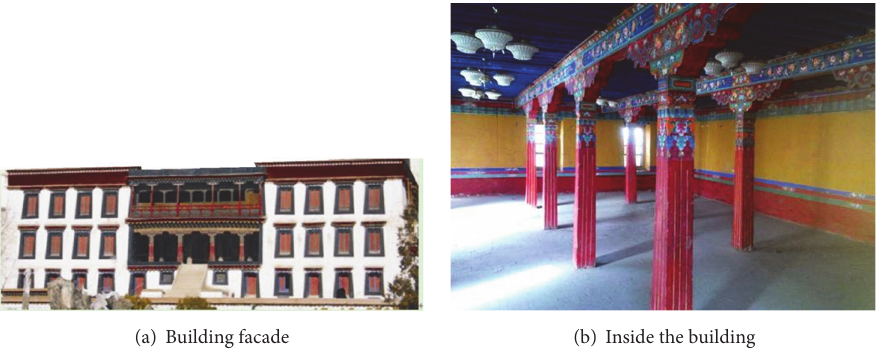
Figure 1: Pictures of typical Tibetan ancient timber